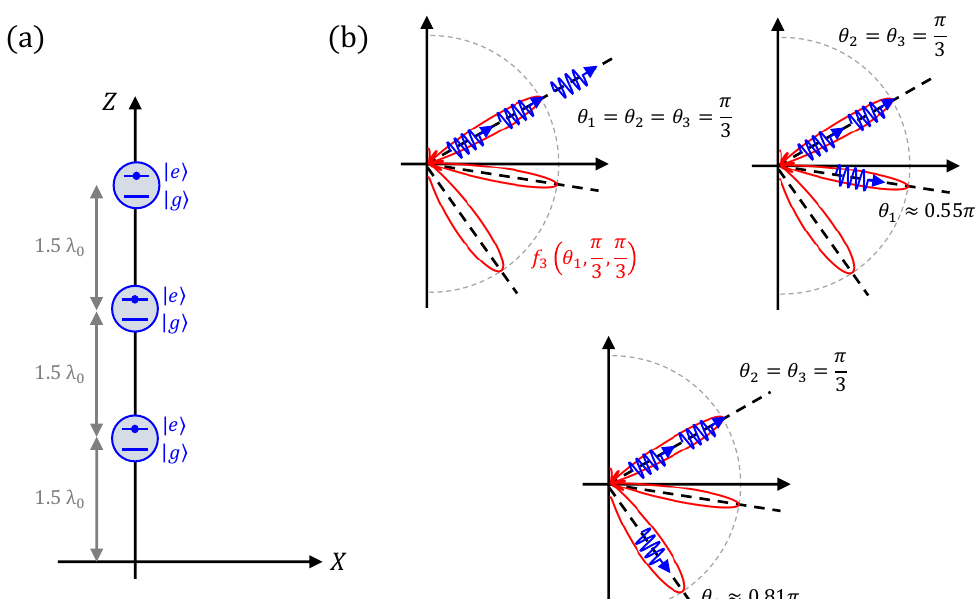
Figure 2. ( a ) Sketch of the geometry. A linear array of N = 3 uniformly spaced quantum emitters with position vectors r n = nd , n = 1,2,3, and d = 1.5 λ 0 , λ 0 being the wavelength at their transition frequency, is oriented vertically along the Z-axis. ( b ) Sketch of three measurement outcomes with the same probability. Top-left: Three photons measured along the same direction θ 1 = θ 2 = θ 3 = π /3. Top-right: Two photons measured along this direction: θ 2 = θ 3 = π /3, and the remaining photon measured along the first − 2 π (cid:39) 0.55 π ) . Bottom-center: Two photons measured along the grating lobe direction θ 1 = acos ( cos π 3 k 0 d direction θ 2 = θ 3 = π /3, and the remaining photon measured along the second grating lobe direction, − 4 π (cid:39) 0.81 π ) . For reference, the red line indicates the N th -order array factor f θ 1 = acos ( cos π 3 k 0 d